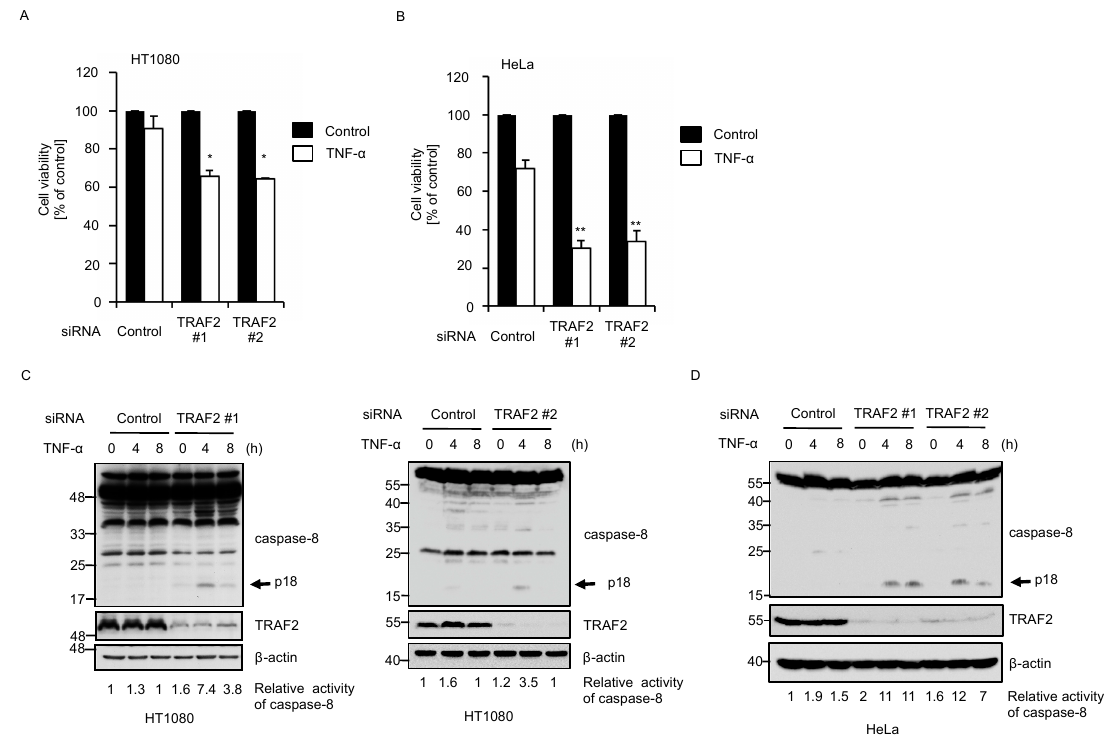
Figure 3. Knockdown of TRAF2 increases sensitivity to TNF- α -induced apoptosis. ( A , B ) HT1080 ( A ) or HeLa cells ( B ) were transfected with siRNA for negative control or TRAF2, and treated 72 h later with ± 50 ng/mL of TNF- α for 24 h. Cell viability was monitored with the phenazine methosulfate (PMS)/ 3-(4,5-dimethylthiazol-2-yl)-5-(3-carboxymethoxyphenyl)-2-(4-sulfophenyl)- 2H-tetrazolium, inner salt (MTS) assay, normalized to untreated control cells and expressed as mean ± SEM ( n = 3). Statistical significance was tested using an unpaired Student’s t -test (vs. control cells); * p < 0.05, ** p < 0.01, (vs. control cells); ( C , D ) HT1080 ( C ) or HeLa cells ( D ) were transfected with siRNA for negative control or TRAF2. After 72 h, the cells were treated with 100 ng/mL TNF- α for the indicated periods. Cell extracts were subjected to immunoblotting with the indicated antibodies. The relative activity of caspase-8 was quantified using ImageJ software.